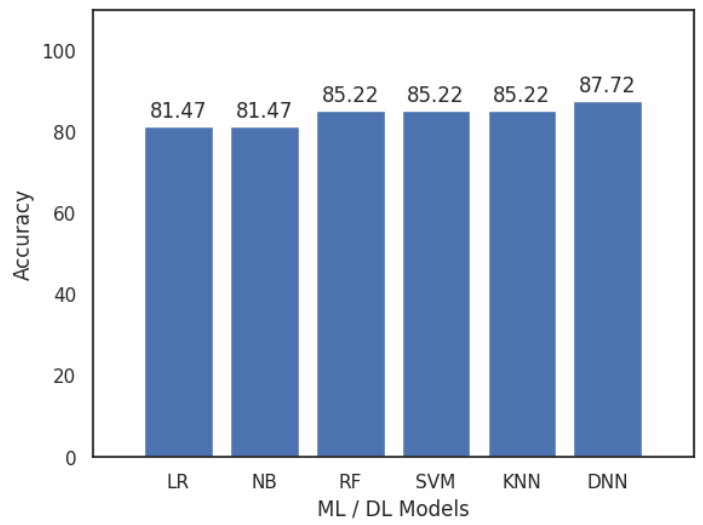
Figure 14. The pictorial representation of comparative accuracy estimation using different ML/DL models based on the stratified five-fold cross-validation.